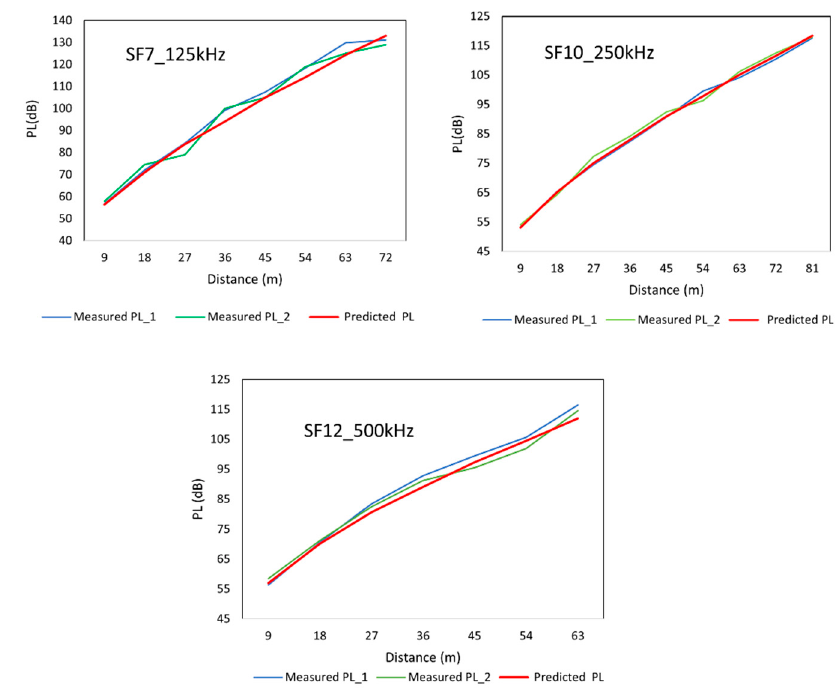
Figure 8. Comparison with Measured PL_2.